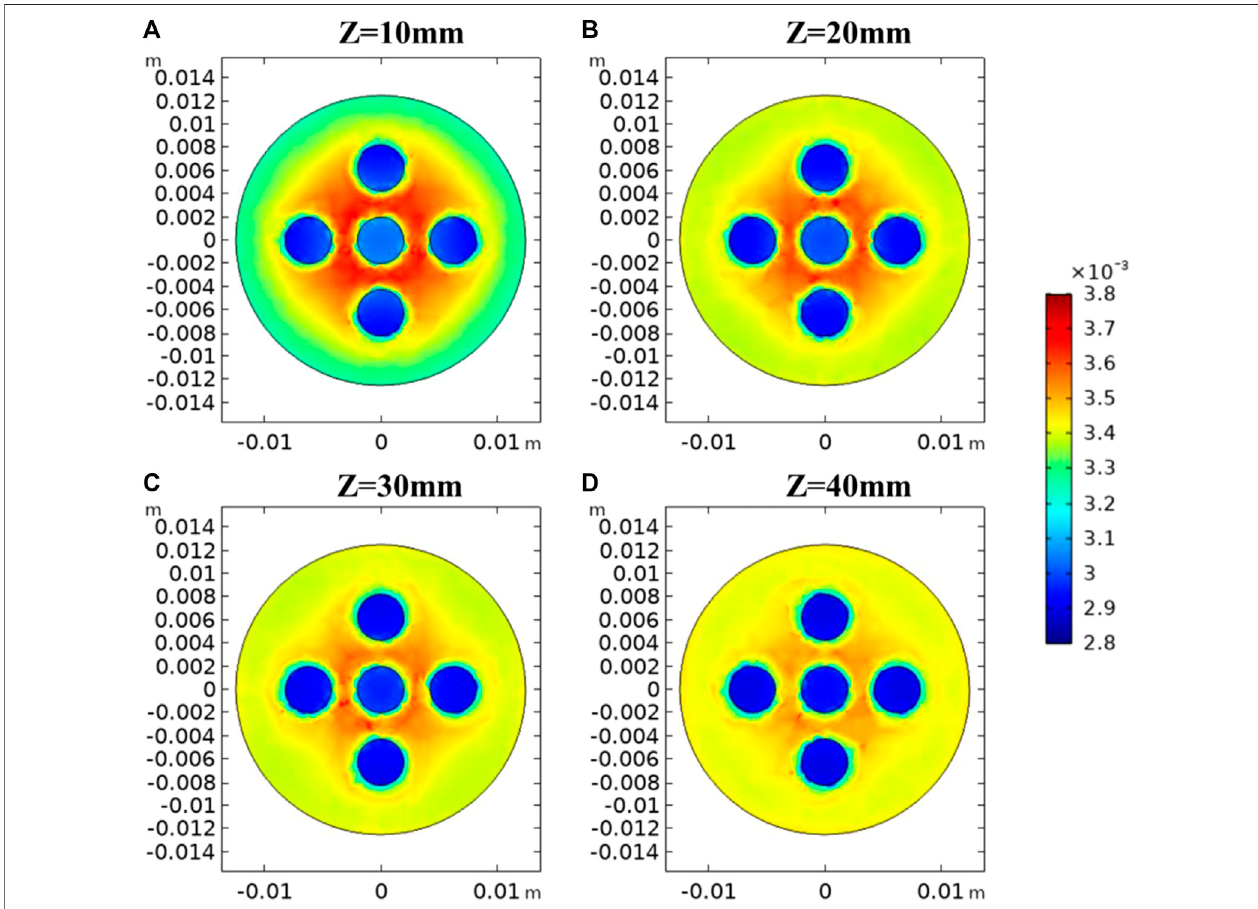
FIGURE 8 | Distribution of axial strains in X-Y planes of (A) Z (cid:2) 10 mm, (B) 20 mm, (C) 30 mm, and (D) 40 mm in the base case.